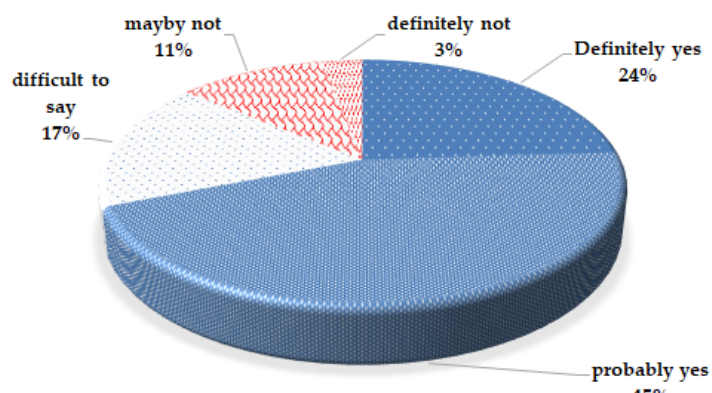
Figure 9. The importance of corporate social responsibility in the decision to purchase a personalized product. Source: own study.